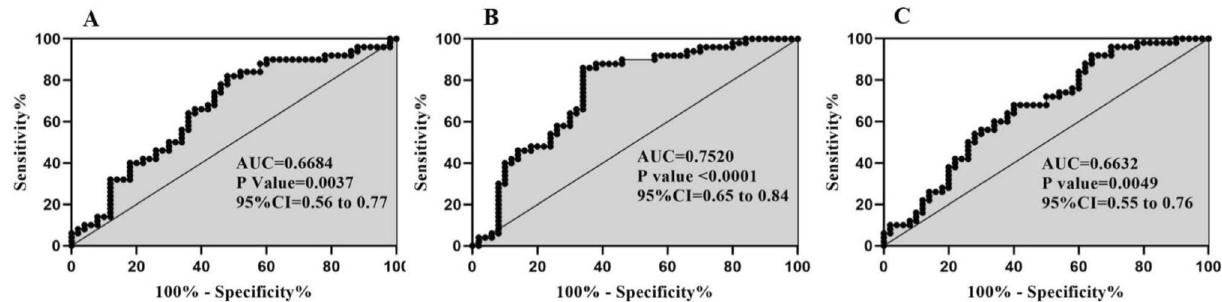
Figure 2. ROC curve analysis of lincRNA-p21 ( A ) lncRNA-ROR ( B ) and lincRNA-PINT ( C ). AUC: area under